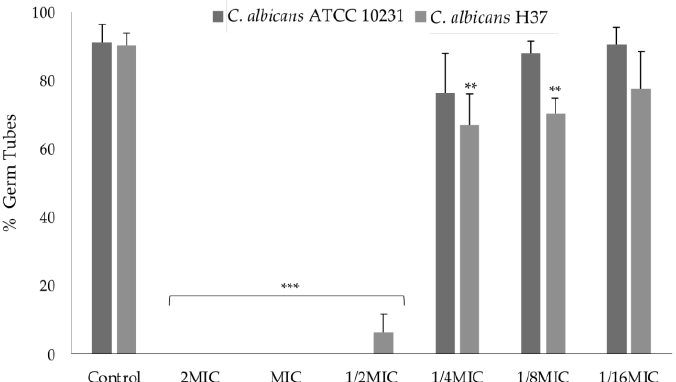
Figure 2. Percentage of germ tube formation in two Candida albicans strains (ATCC 10231 and H37) with different concentrations of compound 1 . Data are shown as mean ± standard deviation of four independent assays. Control included untreated cells and cells treated with 1.28% of dimethylsulfoxide. MIC: Minimal inhibitory concentration. ** p < 0.01, *** p < 0.001 (one-way ANOVA followed by Dunnett´s test).